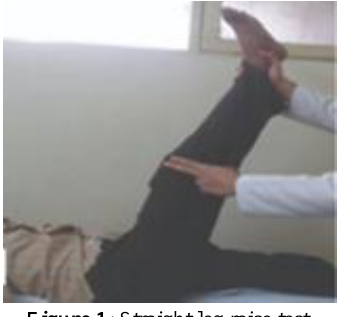
Figure 1 : Straight leg raise test.